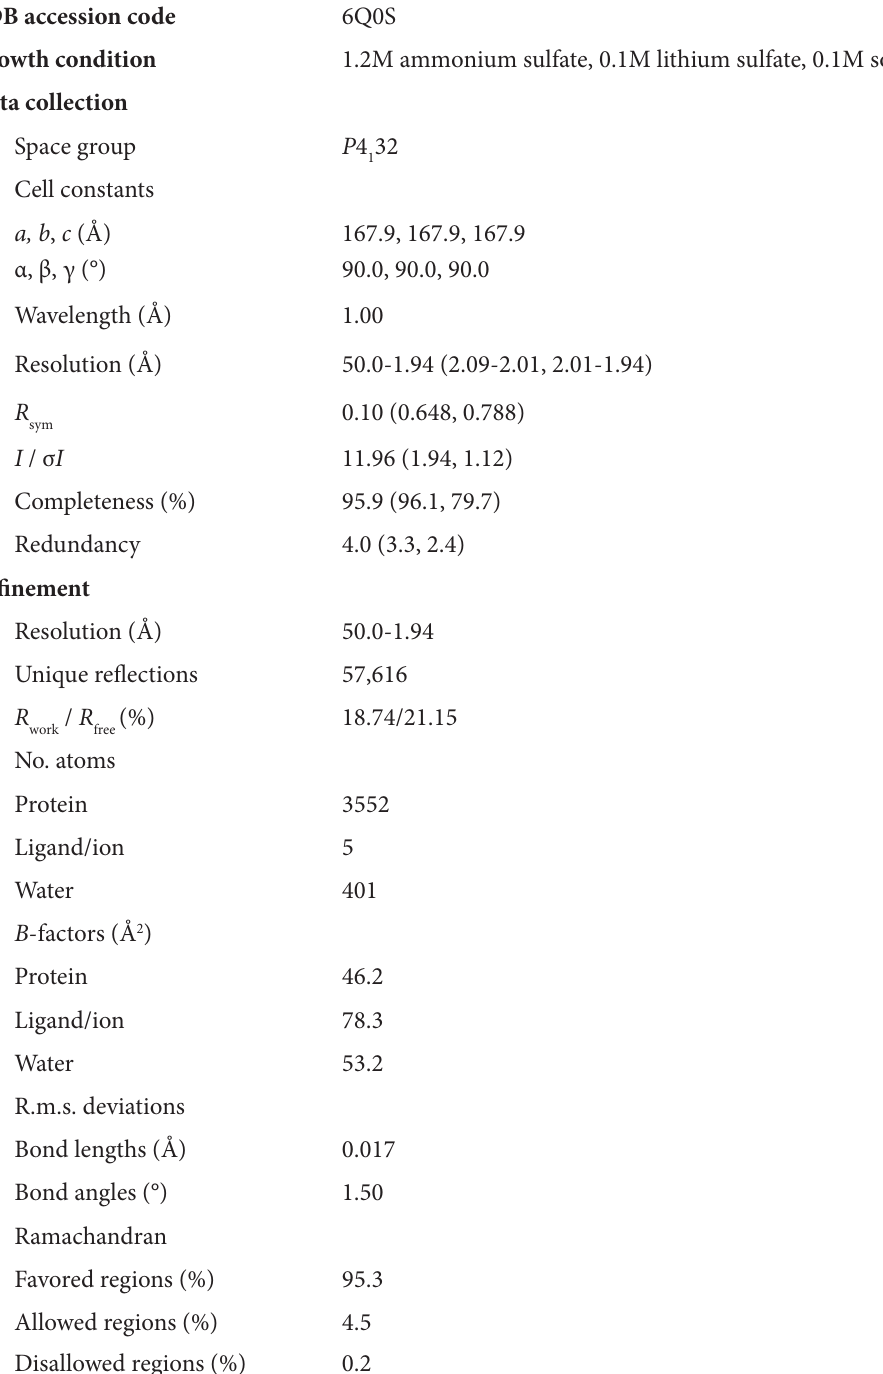
Table 2. Crystallographic data and refinement statistics PDB accession code